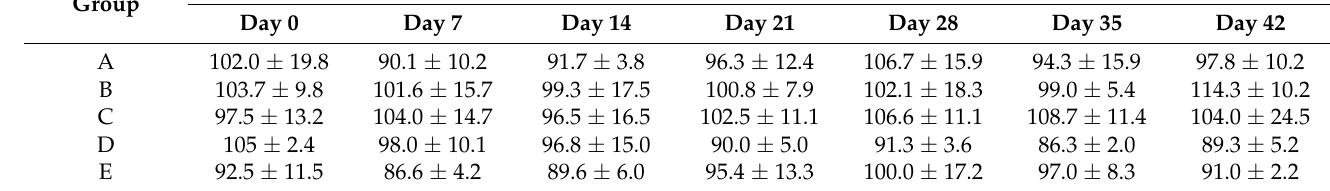
Table 1. Level of plasma SGOT in rats fed with normal diet throughout 42 days of the experimental period. (A) Fed with normal diet for 14 days, followed by high fat diet for another 14 days, followed by normal diet until Day 42 (B); fed with high fat diet for 14 days, followed by normal diet together with atorvastatin for another 14 days, followed by normal diet without atorvastatin until Day 42 (C); fed with high fat diet for 14 days, followed by normal diet together with 100 mg/kg of methanolic extract for another 14 days, followed by normal diet without the extract until Day 42 (D); and fed with high fat diet for 14 days, followed by normal diet together with 50 mg/kg of methanolic extract for another 14 days, followed by normal diet without the extract until Day 42.